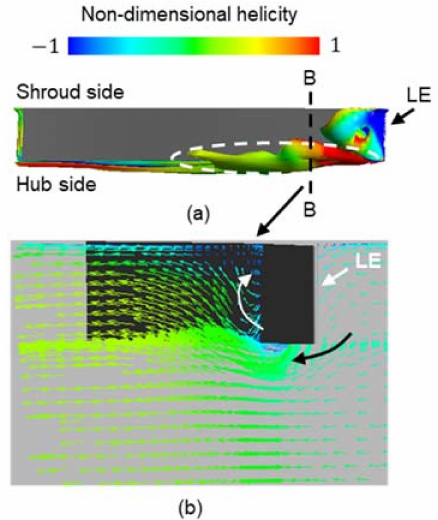
Figure 12. Vortex and induced secondary flow (SVD, ϕ = 0.7 Q d ): ( a ) leading-edge vortex of SVD; ( b ) secondary flow in B–B